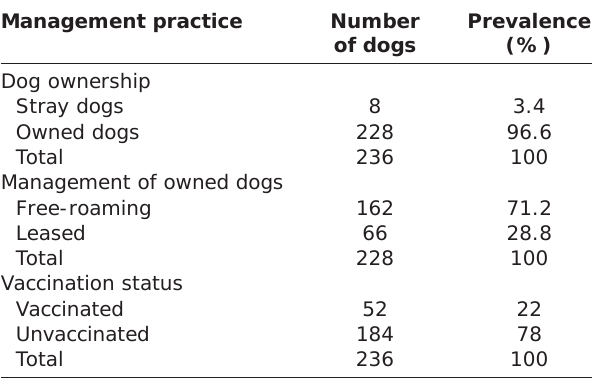
Table-2: Management practices of dogs brought to ABU, VTH, Zaria in bite cases between January, 2002 and December, 2011.